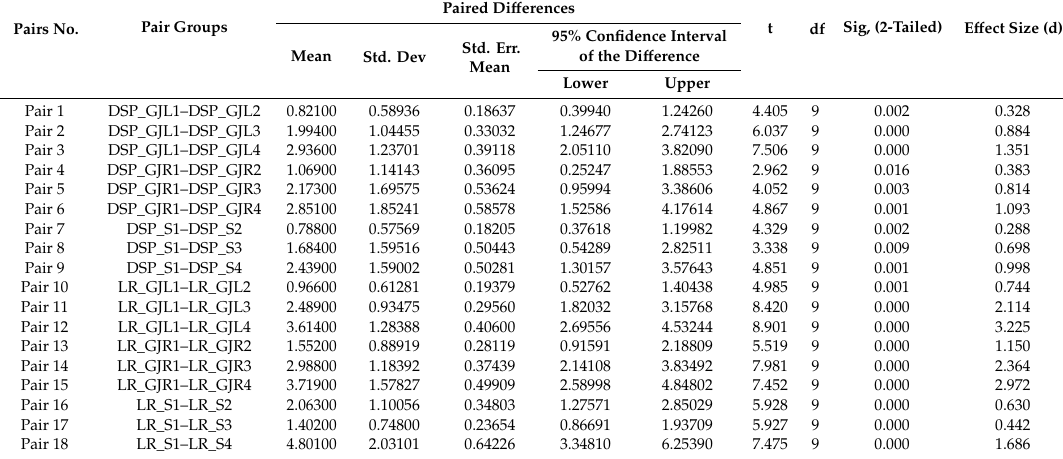
Table 9. Paired t -test Results (CRITERIA = CI (0.9500)) of the Four-Week Training Period.